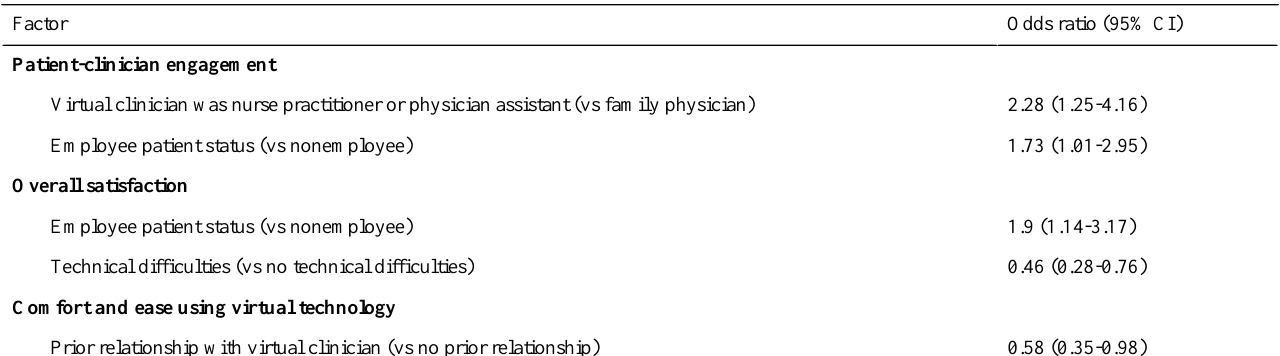
Table 3. Predictors of overall satisfaction, patient-clinician engagement, and comfort and ease with virtual technology.